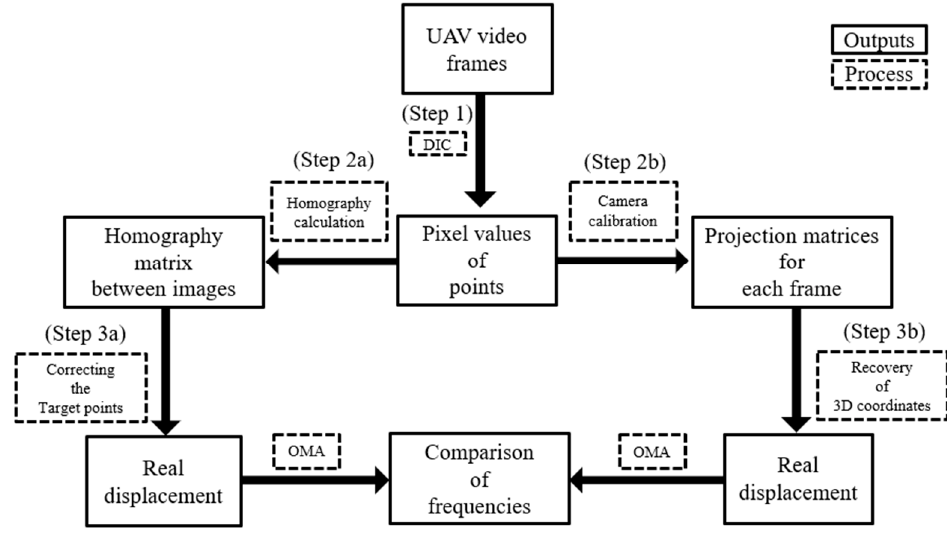
Figure 1. Flowchart of the work.